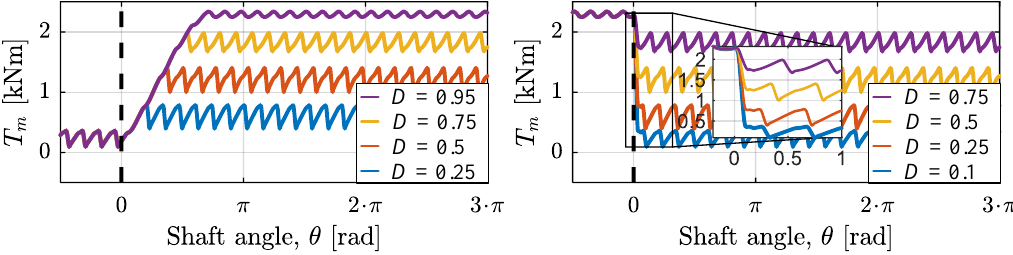
Figure 20. Step-up response ( left plot ) and step-down response ( right plot ) using PSDS Version 1 in the position